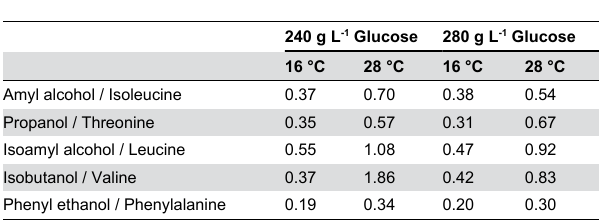
Table 6. Production of fusel alcohols expressed as C-mmol per C-mmol of amino acid precursor transported into the cell.